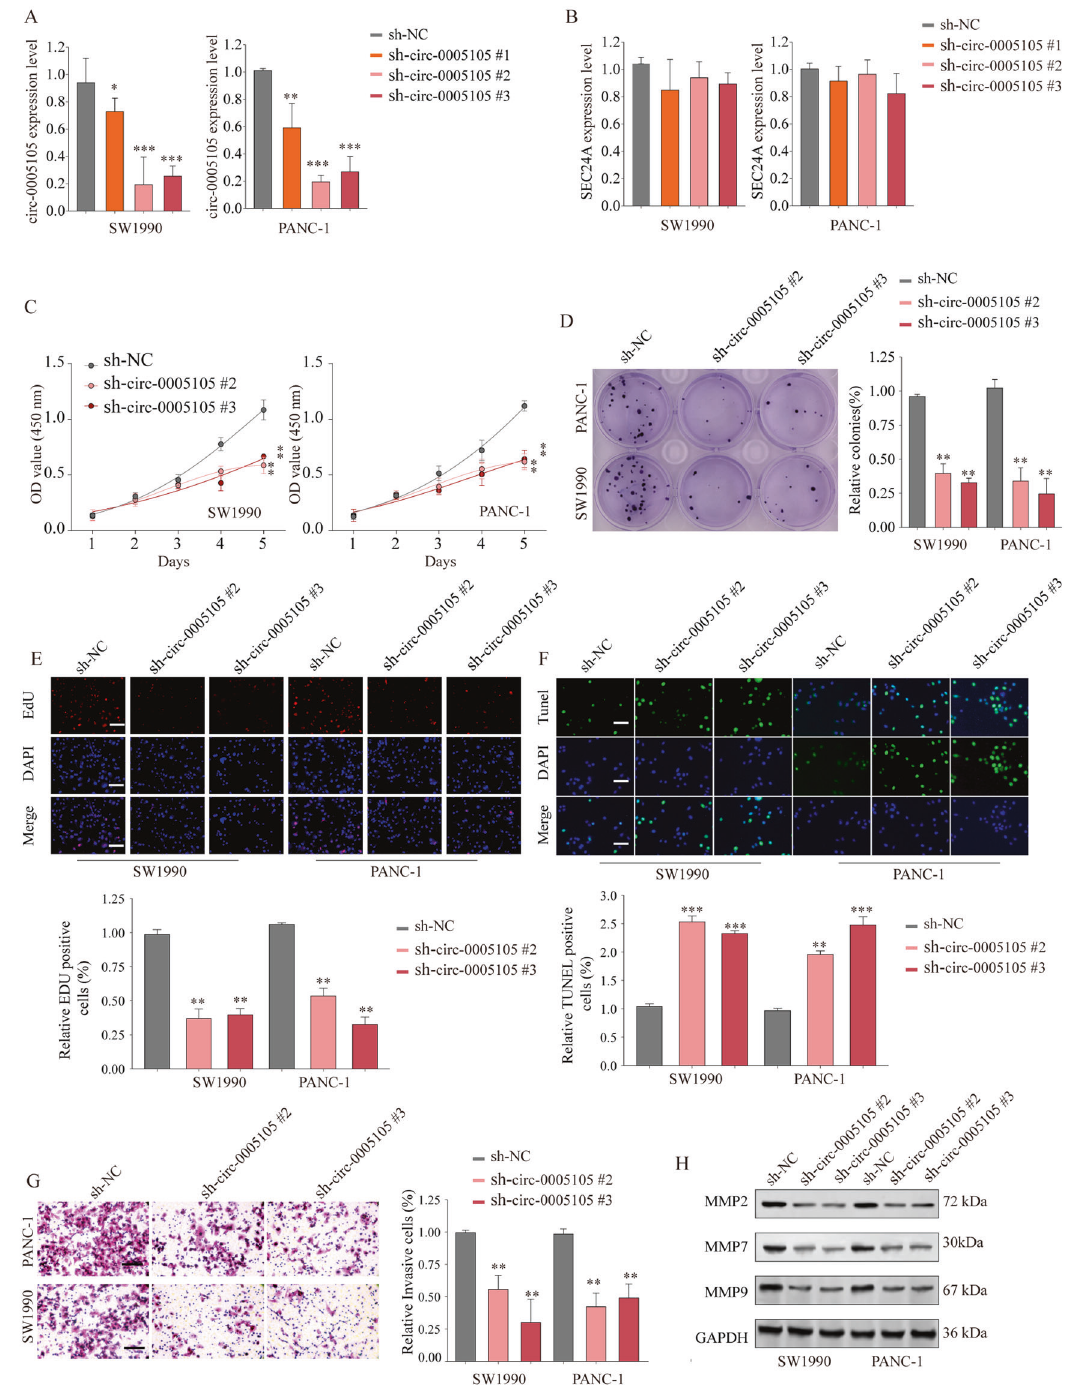
Fig. 3 circ-0005105 knockdown inhibit PDAC cell proliferation and invasion. Pancreatic cancer cell line SW1990 or PANC-1 was transfected with negative control (shNC) or shRNA targeting circ-0005105 (sh-circ-0005105 #1/2/3). The relative expression levels of circ-0005105 ( A ) or SEC24A mRNA ( B ) were analyzed by qRT-PCR. Cell proliferation capability of SW1990 or PANC-1 cells transfected with sh-NC or sh-circ-0005105 #2/3 was determined by CCK-8 assay ( C ), colony formation assay ( F ), and EdU assay ( E ); Scale bar = 50 μ m. F Cell apoptosis was determined by TUNEL assay; Scale bar = 50 μ m. G Transwell experiment was performed to analyze the cell invasion capability of SW1990 or PANC-1 cells transfected with sh-NC or sh-circ-0005105 #2/3; Scale bar = 50 μ m. H Expression levels of MMP-2, MMP-7, and MMP-9 in SW1990 or PANC-1 transfected with sh-NC or sh-circ-0005105 #2/3 were analyzed by western blot. The results are presented as the mean ± SD. * P < 0.05, ** P < 0.01, *** P < 0.001.